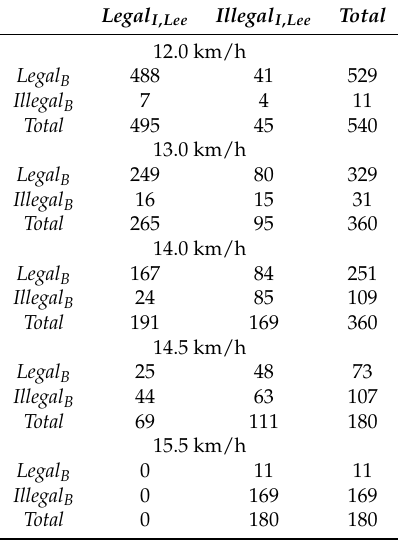
Table A1. Confusion matrix for the step binary classification of Lee’s LOGC T , for tests at 12.0